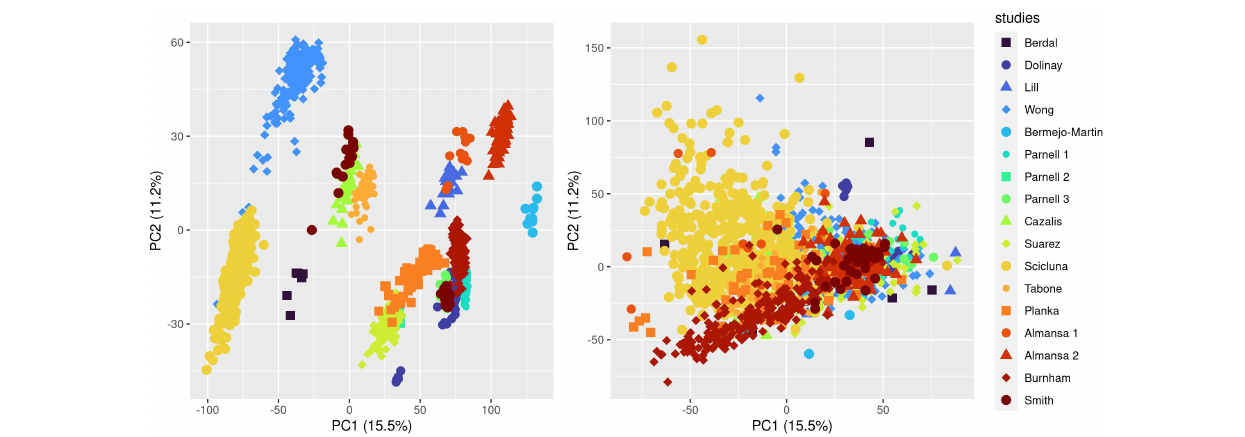
FIGURE 1 | Effect of ComBat co-normalization on patient-level gene expression data assessed by principal component analysis (PCA) across 17 microarray studies. We computed a 2-dimensional PCA plot of individual gene expression data from sepsis patients at day 1 following admission (7,122 genes assessed on 1,437 arrays sampled on 1,437 patients) before (left panel) and after (right panel) ComBat co-normalization using controls with the COCONUT R package. Each of the 17 studies maps to one color, showing how co-normalization attenuates the segregation of individual data points in clusters determined by the study to which they